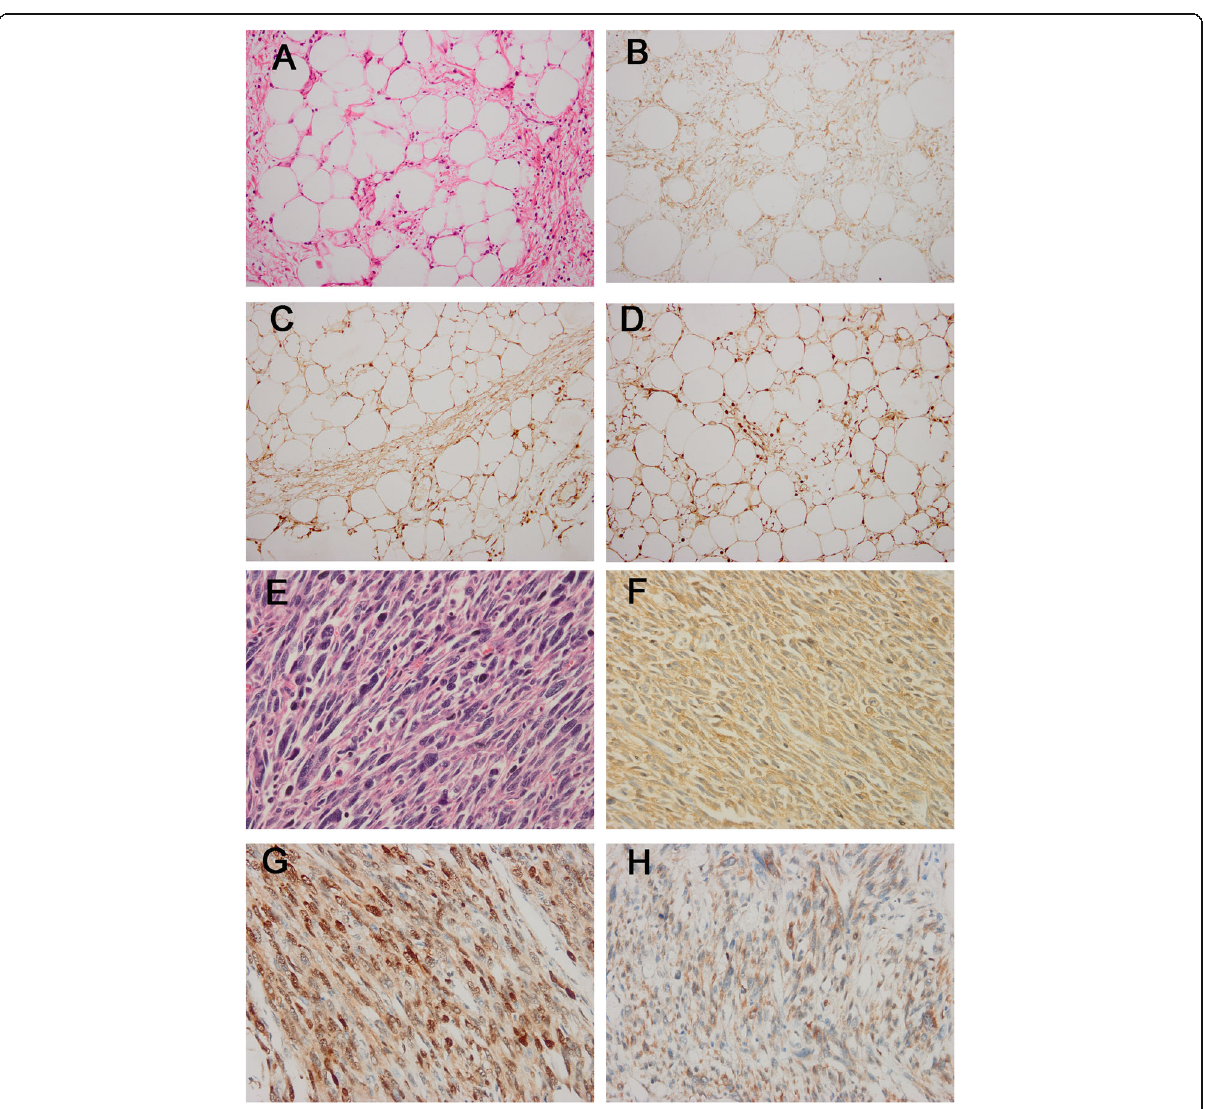
Fig. 4 The histologic features of ALT/WDL and DDL and the corresponding FRS2, MDM2 and CDK4 immunohistochemical staining results. ALT/ WDL ( a ) exhibited strong FRS2 immunostaining ( b ) and showed positive MDM2 ( c ) and CDK4 ( d ) immunostaining results. DDL( e ) had strong FRS2 ( f ) immunostaining and positive MDM2 ( g ) and CDK4 ( h ) immunostaining results. (a, e, haematoxylin and eosin; b-d,f-h, immunostaining) (original magnification, a-d × 200, e-h ×